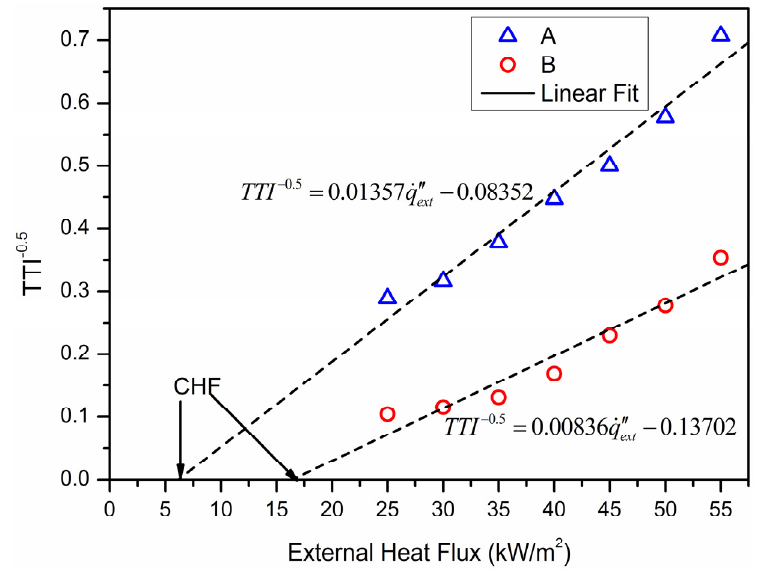
Figure 3. The change of ignition time with external heat flux.